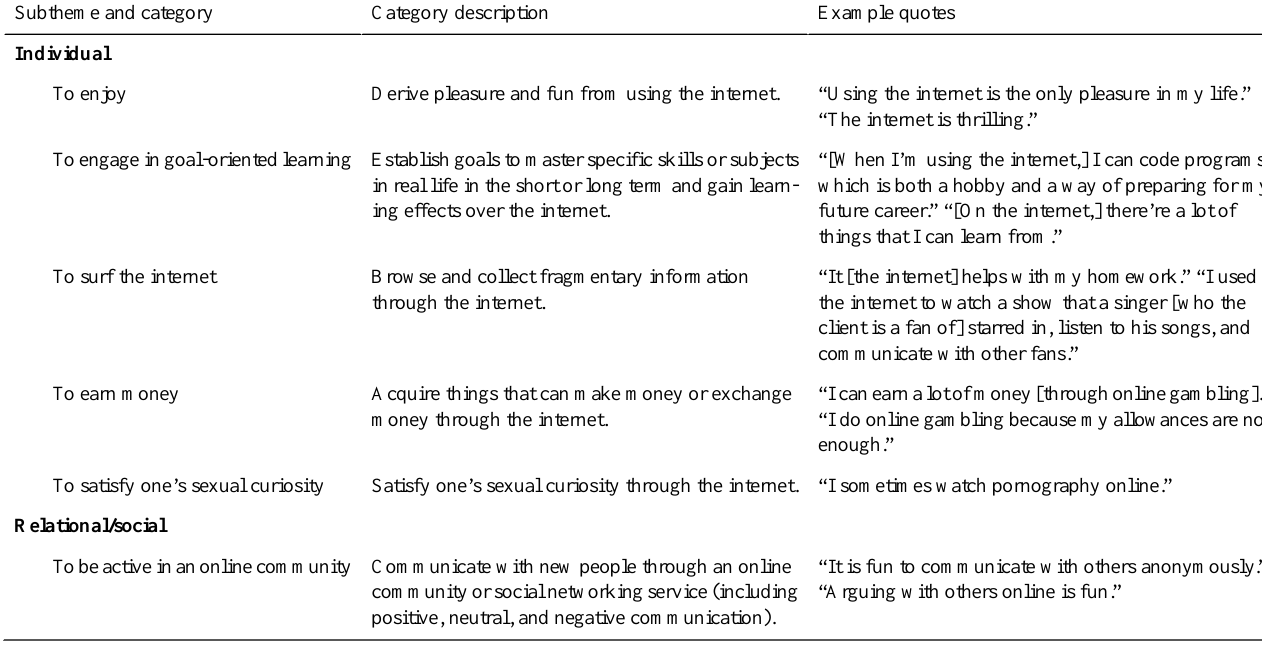
Table 3. Internet utility categories of problematic internet use